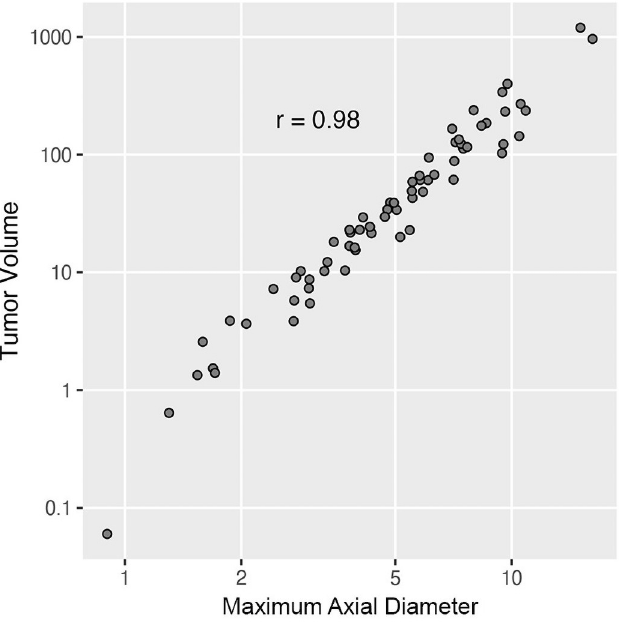
Fig 1. Tumor volume and axial longest diameter in canine lung tumors. The longest diameter in an axial plane and volume were automatically generated for 67 lung tumors in 65 dogs. Data are shown as individual points, with strong correlation between longest diameter and volume as determined by Pearson’s product moment correlation.